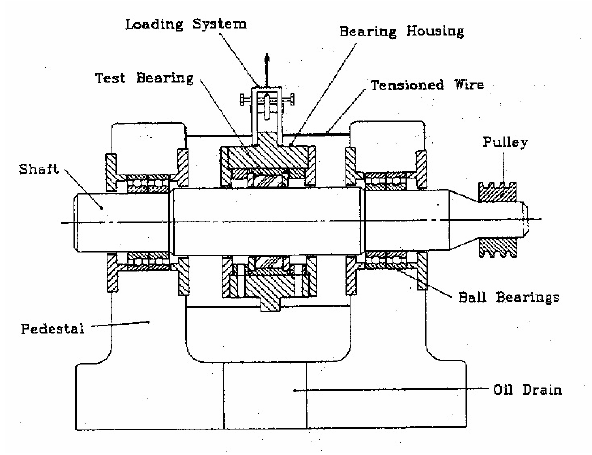
Fig. 2. Brockwell and Dmochowski [44] test rig.